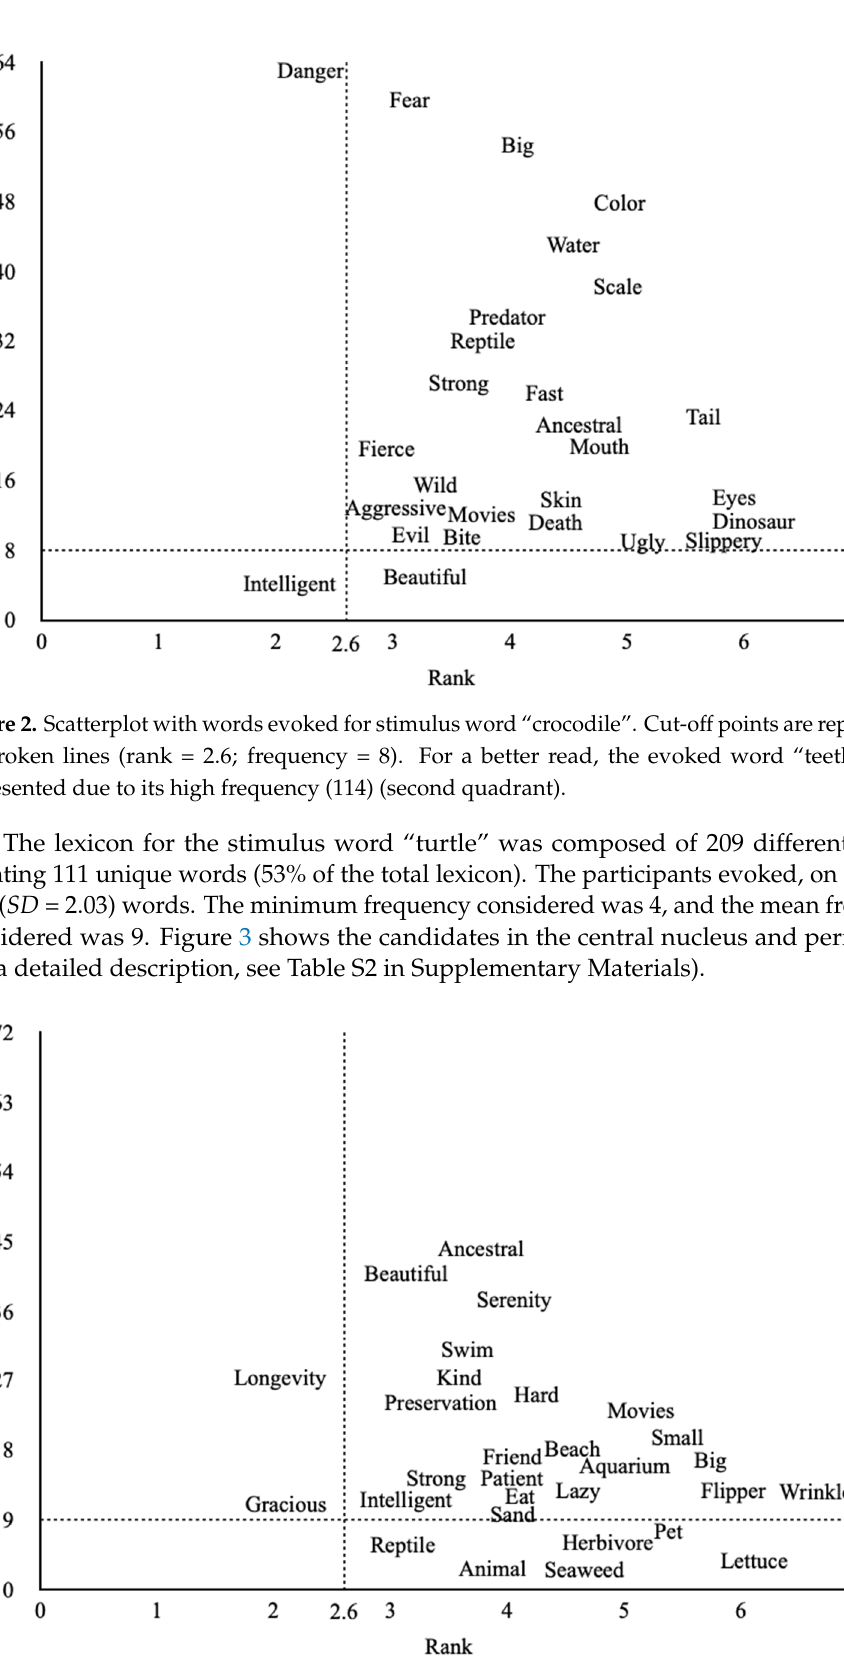
Figure 3. Scatterplot with words evoked for stimulus word “turtle”. Cut-off points are represented by broken lines. For a better read, the evoked words “shell”, “slow” and “sea” are not represented due to their high frequencies (116, 102 and 79, respectively) (second quadrant).